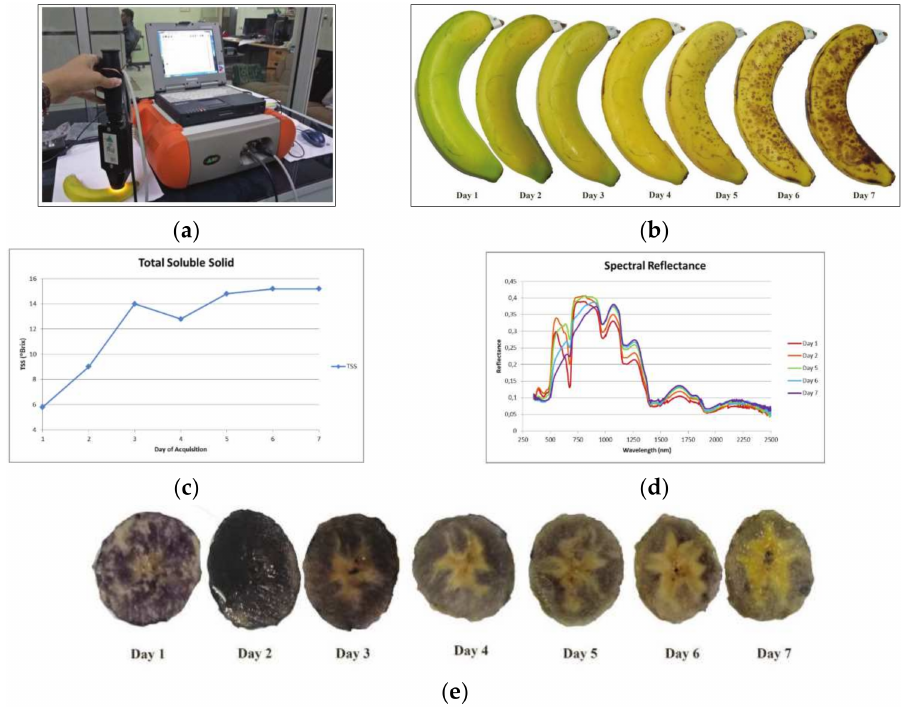
Figure 9. Spectral reflectance acquisition of Cavendish banana using ASD Hyperspectral spectrora- diometer ( a ) in seven different day observations ( b ), and its relationship to Brix and Starch content change ( c – e